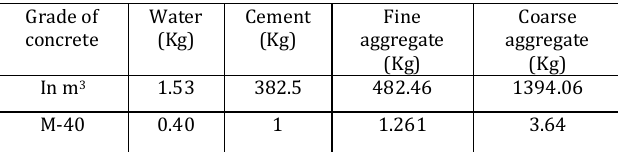
Table 3: Mix proportions without RHA